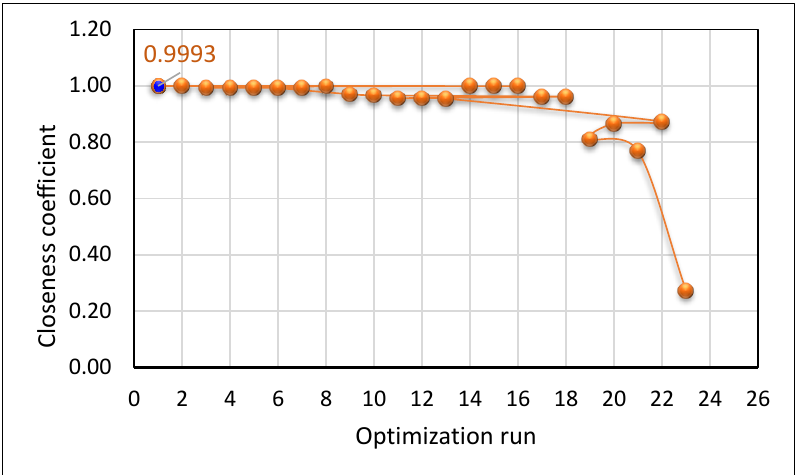
Figure 14. Performance of ABC Algorithm.